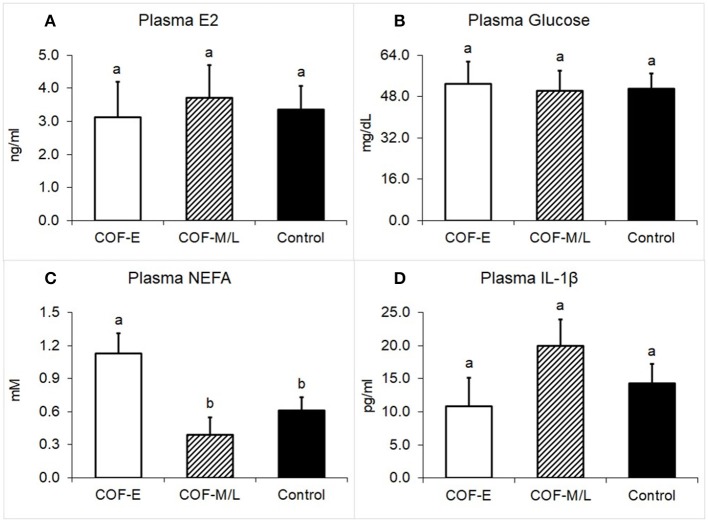
Plasma concentration for (A) E2, (B) Glucose, (C) NEFA, and (D) IL-1β in cows diagnosed with COF at early (COF-E) and mid-late (COF-M/L) lactation and the control cows. Different letters (a,b) represent different (P < 0.05) least-square means. Error bars represent the mean standard error.